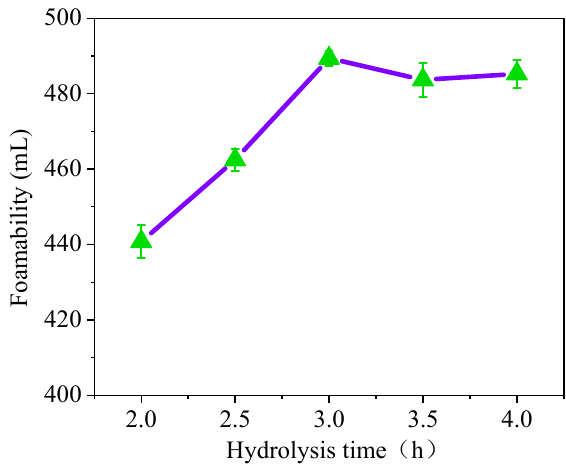
Figure 3. Effect of hydrolysis time on foaming ability.